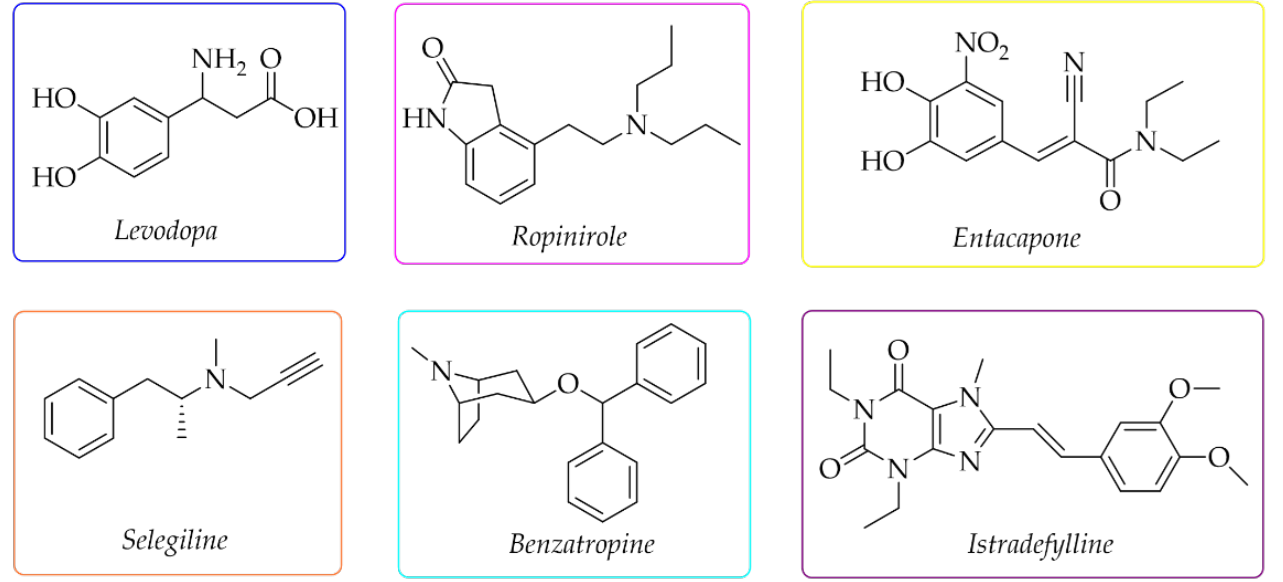
Figure 1. Chemical structures of the most commonly used drugs in Parkinson ’ s disease therapy and istradefylline . The growing number of PD patients necessitates the search for new strategies to combat this disease. The current research directions are shown in Figure